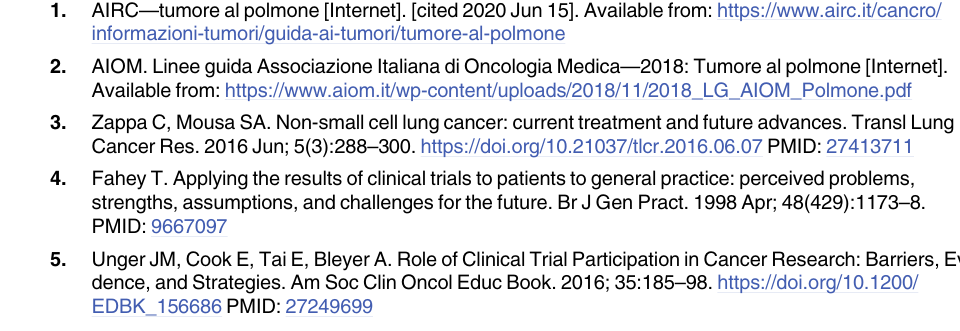
S1 Fig. Positive predictive value (PPV) and sensitivity (SE) of first version of the algorithm and both algorithm modifications. The figure shows the validity measures of the first and both algorithm modifications. PPV was represented in red and SE in green (dark green–higher value of SE; light green–lower value of SE). S1 Table. SNOMED morphology codes description. The table shows for each specific code the respective description. S2 Table. Keywords translation in English. The table shows the translation of each Italian keywords to English. S3 Table. Manual validation results of first version and final version of the algorithm. The table shows the results of the manual validation (malignancy; topography; morphology and origin) of the first and the final version of the